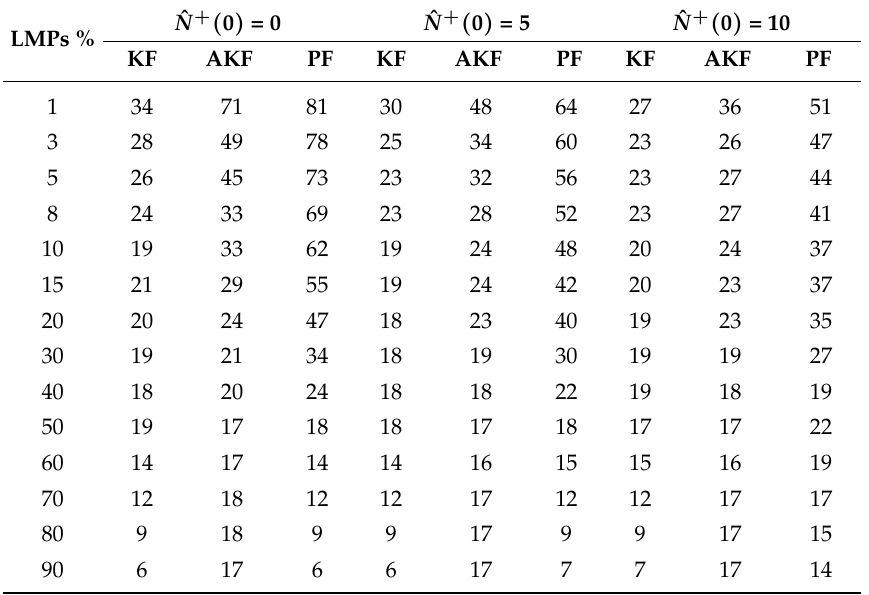
Table 3. RRMSE values for the KF, AKF, and PF approaches using different initial vehicle count estimates (i.e., 0, 5 and 10) for different LMPs.